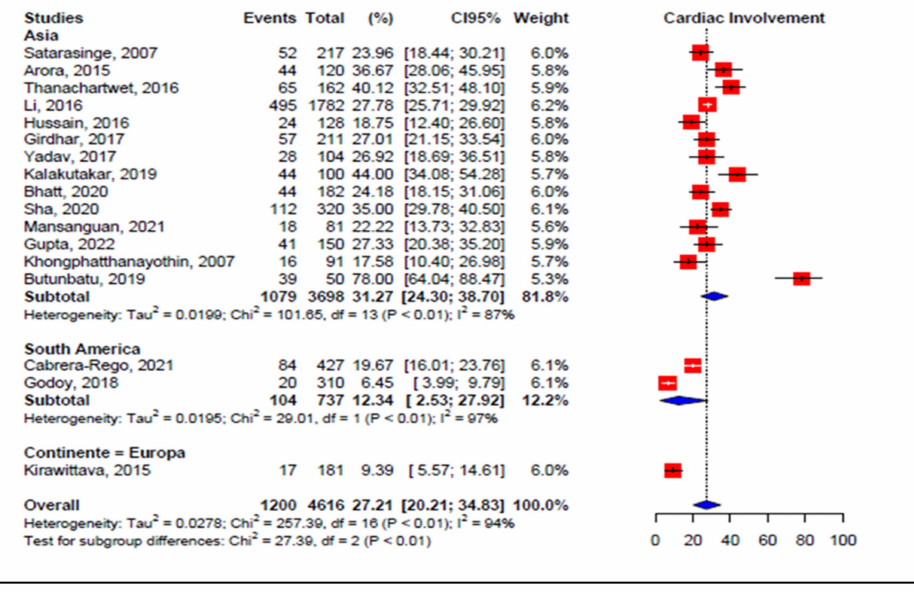
Figure 4. Forest plot comparison of the frequency of cardiac events in patients with dengue, grouped by continent. Legend : CI—confidence